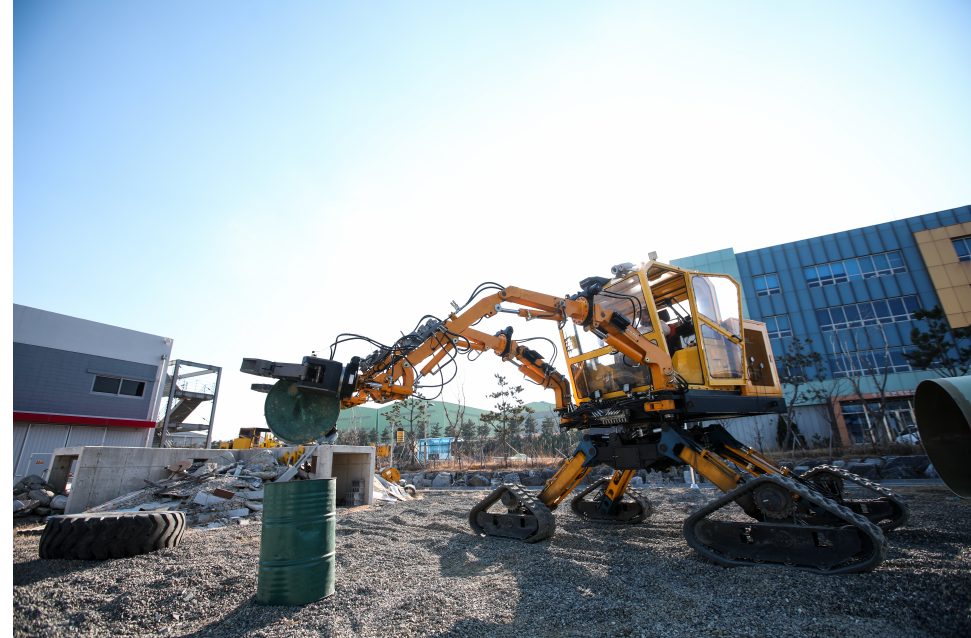
Figure 1. The dual-arm manipulator for special-purpose disaster-response machinery from KITECH.